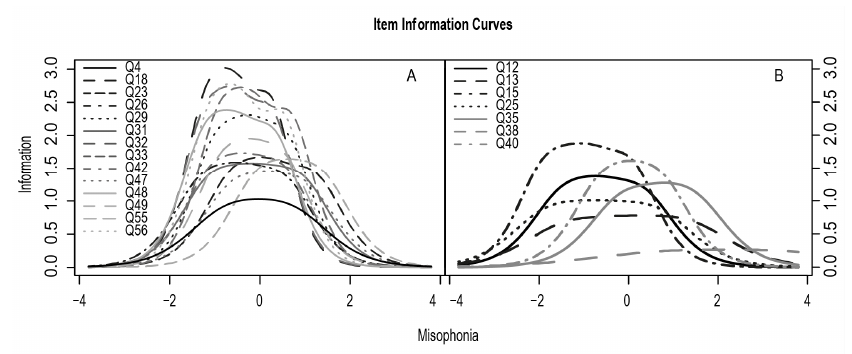
Figure 3. ( A ) Item information curves for MisoQuest and for ( B ) items that were